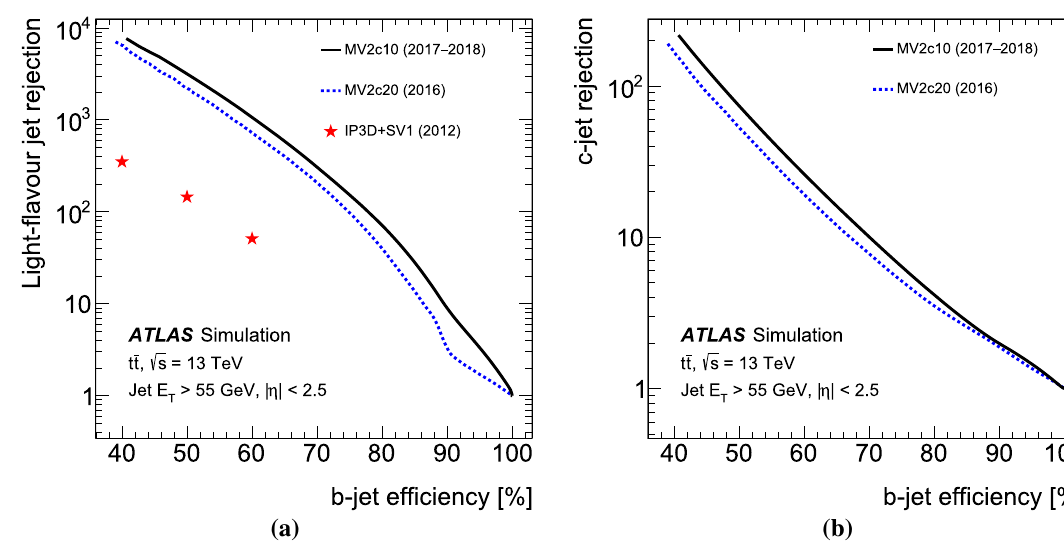
c -jets or light-flavour jets following the particle-level